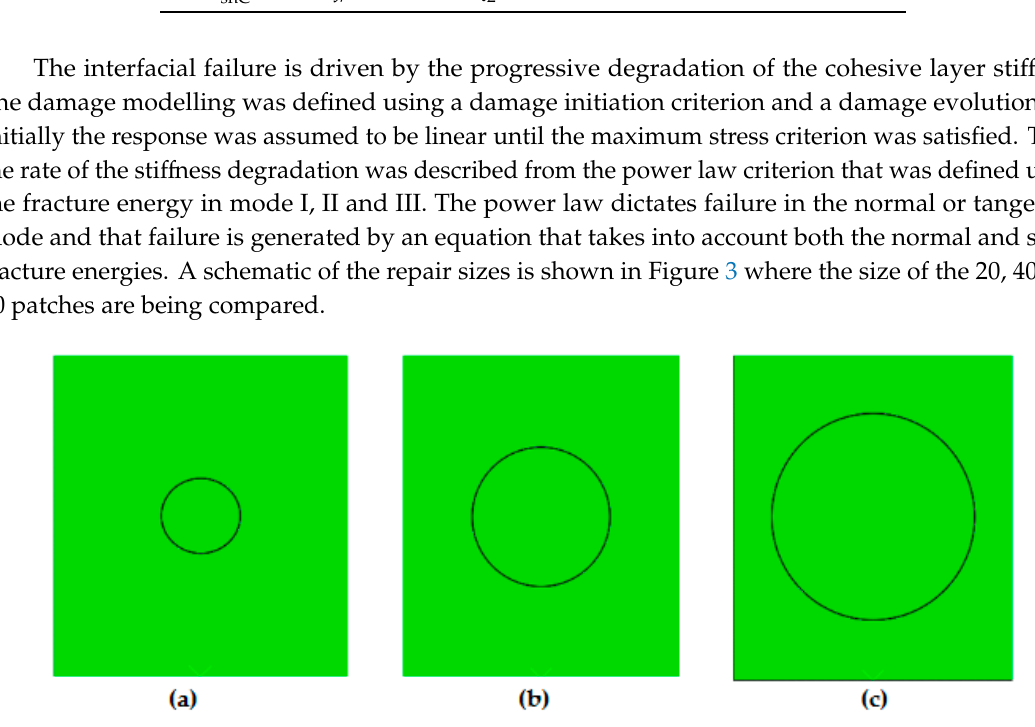
Figure 3. Sketch comparison of repaired plates with scarf ratios of ( a ) 20; ( b ) 40; and ( c ) 60.